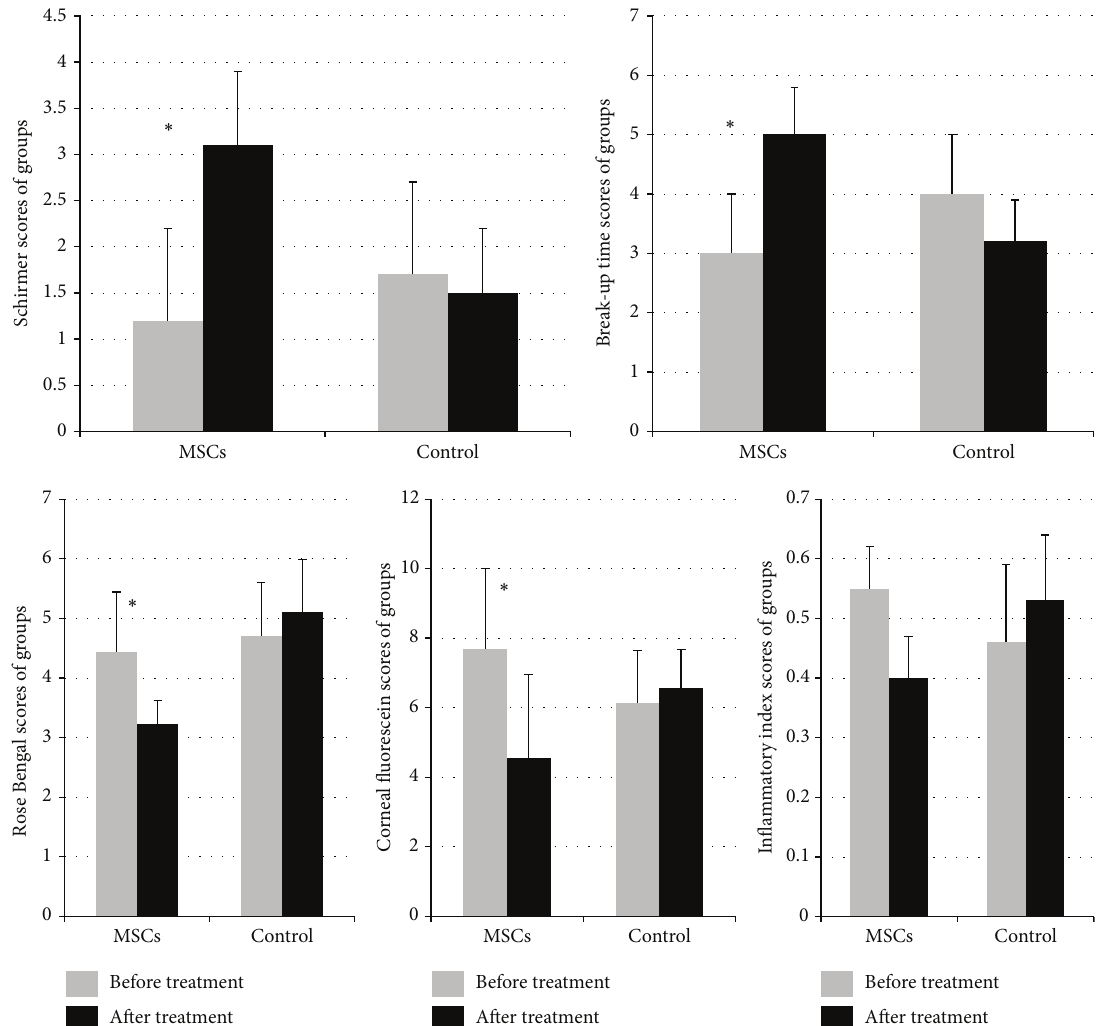
Figure 1: Ocular surface evaluation tests (Schirmer score, break-up time, fluorescein staining, and Rose Bengal staining) and corneal inflammatory index scoring test scores of groups. A marked increase in aqueous tear volume was observed in MSCs-treated rats, while aqueous tear volume decreased in PBS-treated controls after one week of therapy. The mean BUT score increased in MSCs-treated rats, while the score decreased in the PBS-treated group after one week of therapy. The mean Rose Bengal score decreased in MSCs-treated rats, while scores increased in PBS-treated controls. The mean fluorescein score decreased in MSCs-treated rats, while the score increased in PBS-treated controls after one week of therapy. The mean inflammation index scores decreased in MSC-treated rats, while scores increased in PBS-treated controls after one week of therapy. ( ∗ = 𝑃 < 0.05 ) within PBS-treated group tear volume and break-up time levels were slightly decreased and Rose Bengal score, the mean fluorescein score, and the mean inflammation index scores were slightly increased with no significant difference ( 𝑃 < 0.05 ) and this might be due to sustained effect of 0.2% BAC or toxicity of diagnostic dyes and repeated manipulations.